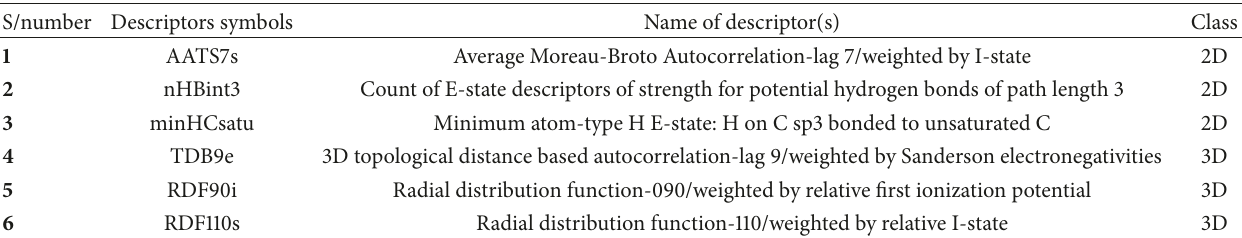
Table 6: List of some descriptors used in the QSAR optimization model.